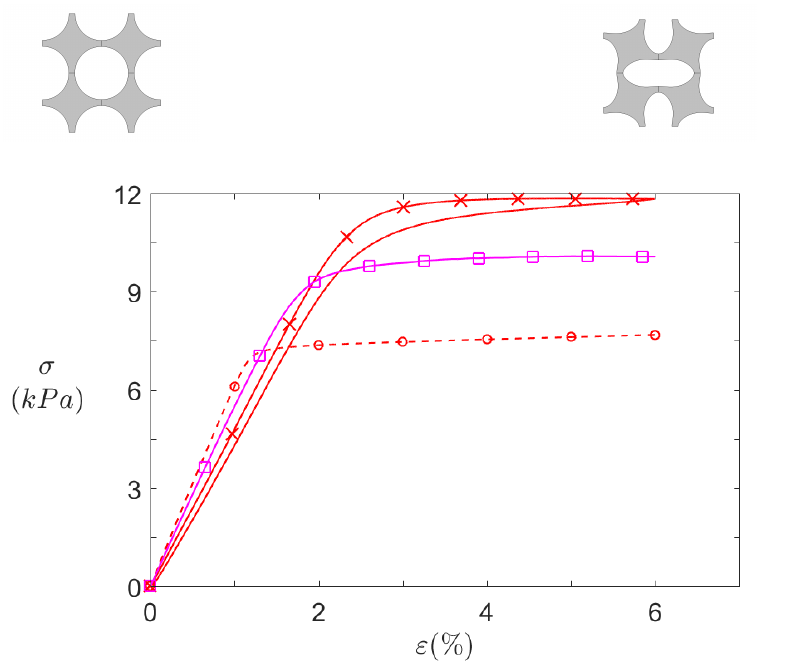
Figure 13. Static behaviour of S R pattern under axial compression. Effective stresses σ against compression axis ( Y ) for 2D infinite plates computations, 3D finite 8 × 7 structures computations, and experimental 8 × 7